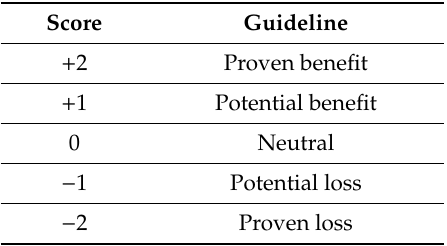
Table 2. Scoring scale